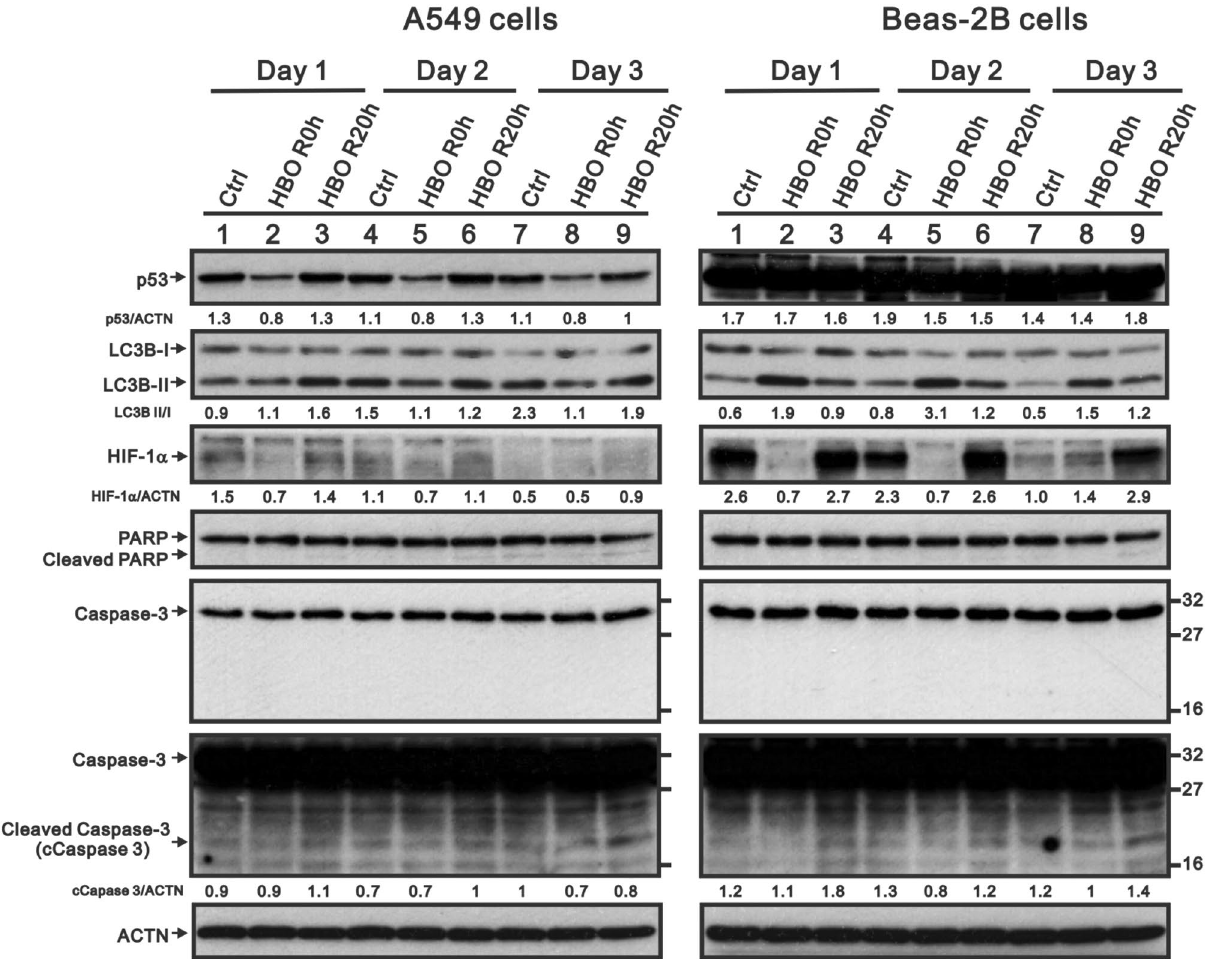
Figure 6. The HBOT effect on stress proteins on A549 and Beas-2 cell lines. The A549 and Beas-2 cells were treated with HBOT at 3.5 ATA for 90 min and then lysates were subject to the Western analysis for antibodies against p53, LC3B, HIF-1α, PARP, Caspase 3, and control protein ACTN. The results are representative of two independent experiments. Quantitative analysis of the western blot was listed under each